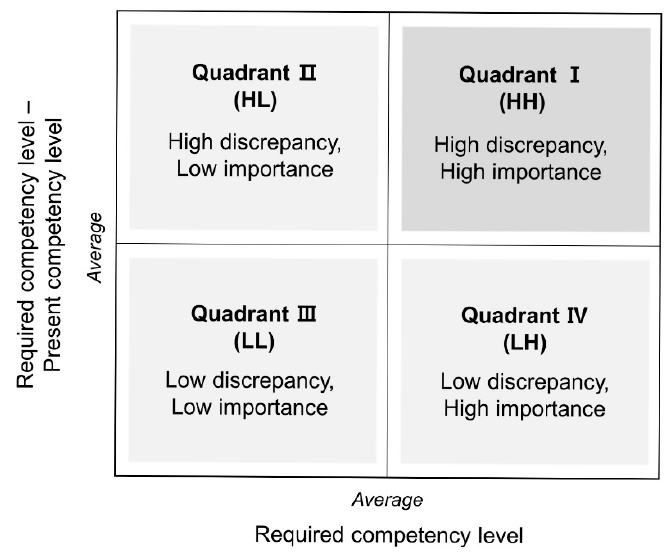
Figure 1. Locus for focus (LF)